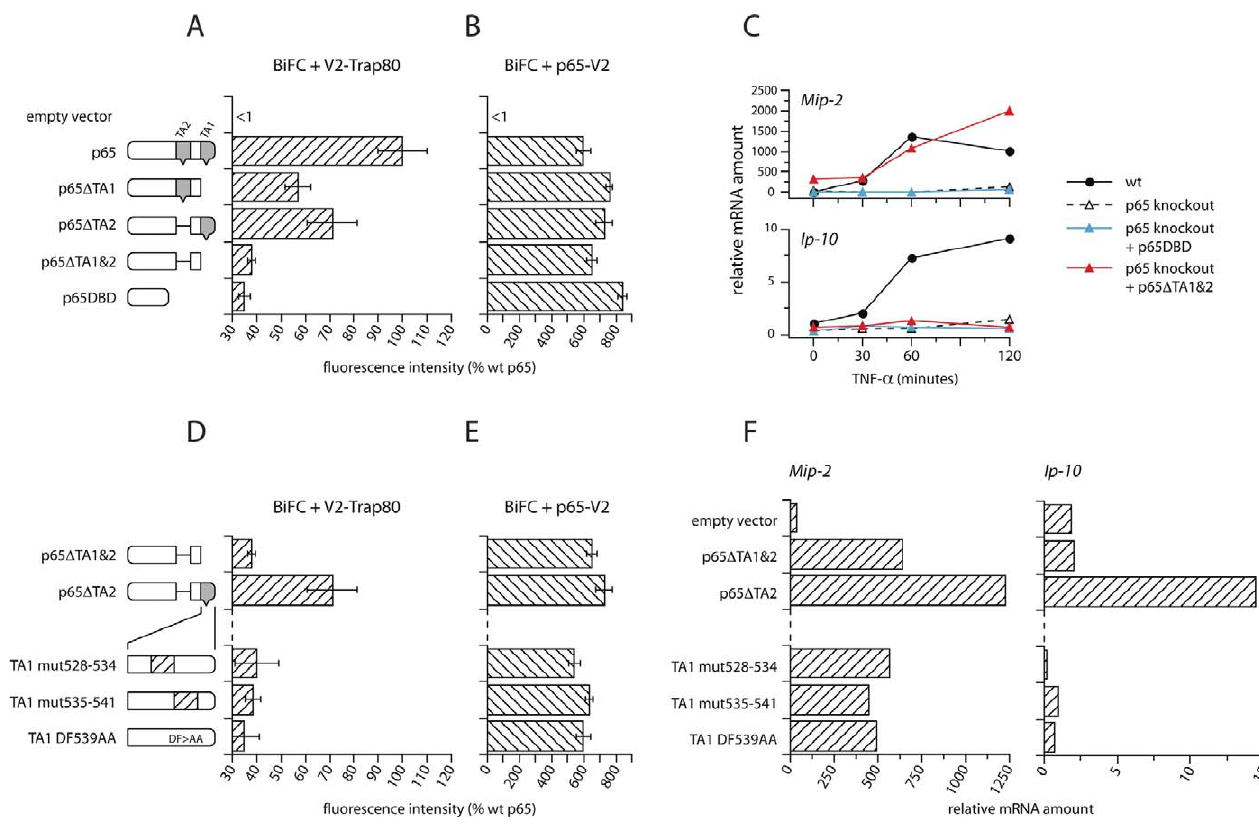
Figure 5. Mutations of p65 That Prevent Interaction with Trap-80 (A) Deletion of TA1 and TA2 prevents the interaction of p65 with Trap-80. (B) All p65 deletion mutants tested can still homodimerize. (A, B, D, and E) depict fluorescence intensities of HEK-293 cells after co-transfection with vectors expressing the indicated mutants of p65 fused to Venus fragment 1 (V1), and either V2-Trap-80 (A and D) or p65-V2 (B and E). Intensities are expressed as a percentage of the level in cells co-expressing p65-V1 and V2-Trap-80 (shown in [A]). The residual ; 30% fluorescence seen with the p65 DBD in (A) is similar to the level seen in cells co-expressing V1 and V2 fused to control, noninteracting proteins. Error bars indicate standard errors of independent transfections. The results presented here are representative of two to four experiments. (C) Deletion of TA1 and TA2 prevents expression of Ip-10 but does not affect expression of Mip-2 . p65-knockout fibroblasts were transduced with retroviruses driving expression of the p65 DBD (blue triangles) or of p65 D TA1&2 (red triangles), and expression of Ip-10 and Mip-2 was compared to wild-type and untransfected p65-knockout cells. (D) Mutations in TA1 that prevent the interaction of p65 D TA2 with Trap-80. (E) All p65 mutants tested can still homodimerize. (F) Mutants that do not interact with Trap-80 cannot drive expression of Ip-10 , but expression of Mip-2 is unaffected. Expression of Mip-2 (left) and Ip-10 (right) mRNA in p65-knockout fibroblasts transduced with retroviruses expressing the indicated p65 mutants, after stimulation for 1 h with TNF- a .